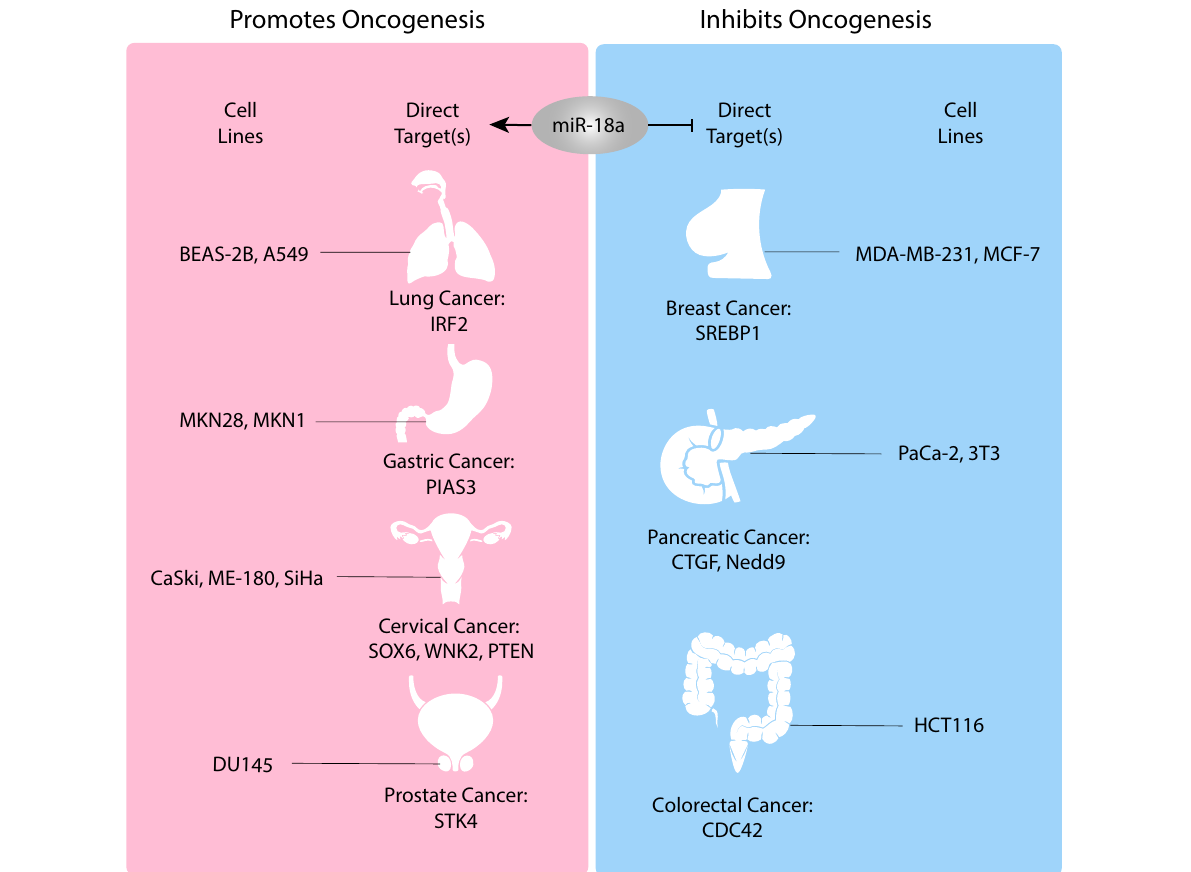
Fig. 4 The dual functional role of miR-18a in different human cancers. miR-18a is overexpressed in various human cancer cell lines and promotes oncogenesis in lung, gastric, cervical, and prostate cancers but inhibits oncogenesis in breast, pancreatic, and colorectal cancers. This dual function is observed both in different human cancer types and in cancers of the same organ or